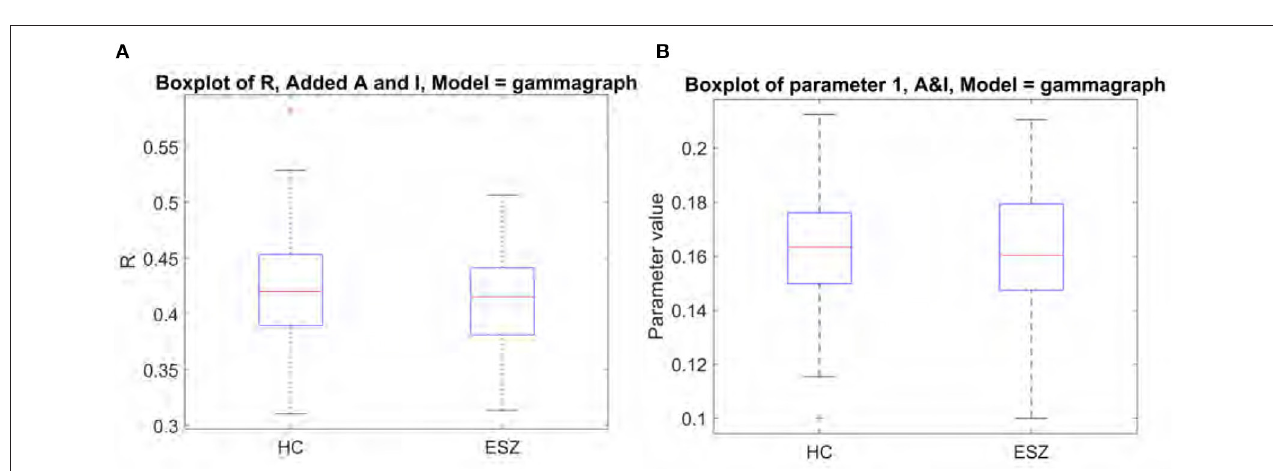
FIGURE 6 | Model performance when using structural connectome comprised of original SC, adjacency matrix, and interhemispheric matrix. (A) Histogram of R scores. (B) Histogram of fitted parameter. (C) Optimal structural connectome. (D) Mean functional connectome across healthy subjects. (E) Mean model-predicted functional connectome.